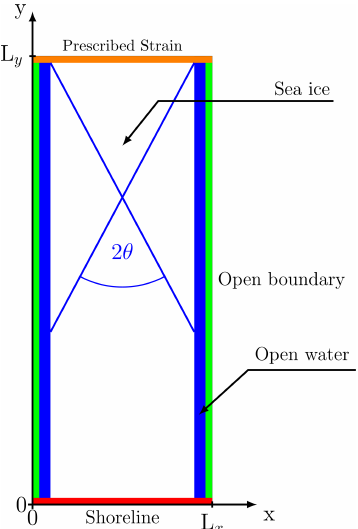
Figure 5. Model domain with a solid wall at y = 0 (red), Dirichlet boundary conditions where u is 0 at y = 0, and prescribed velocities at y = L y . Open boundaries at x = 0 ,L x (green) with Neumann boundary conditions. For the conservation of mass, ice thickness, and concentration equations ( h , A ), Neumann boundary conditions are used on all boundaries. θ is the measured fracture angle with respect to the vertical; the blue line represents an